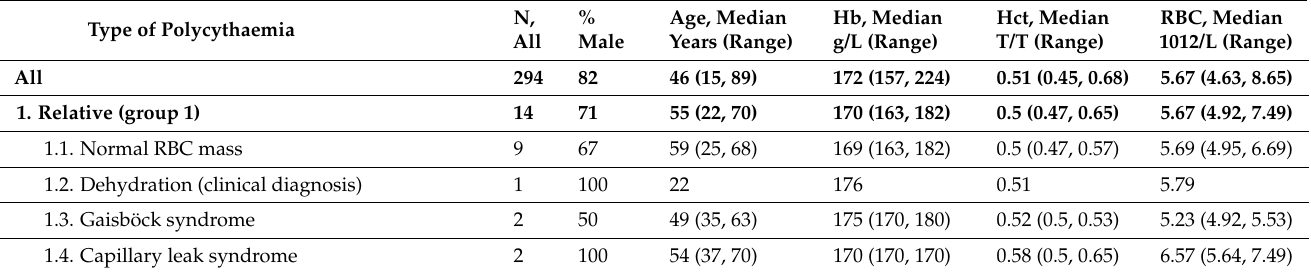
Table 1. Characterisation of underlying pathophysiological mechanism of polycythaemia: causes, demographics and laboratory values of JAK2 unmutated polycythaemia patients (N =